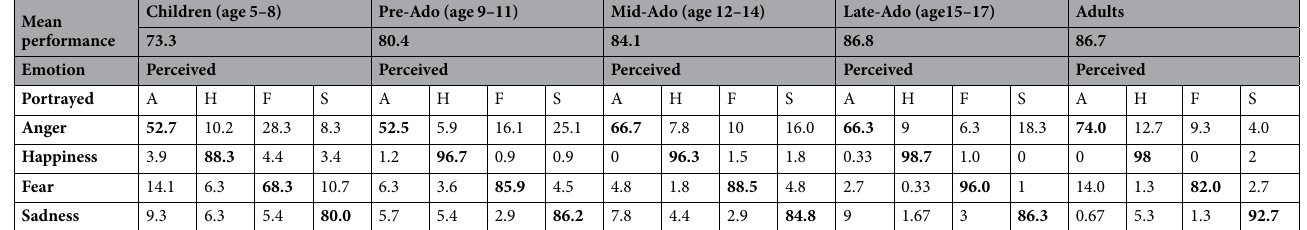
Table 3. Percentage of responses from the 4 emotions categories for each portrayed emotion. Diagonal represent the percent correct recognition. In the top line is the mean performance across the four emotions. A: Anger; H: Happiness; F: Fear; S: Sadness.